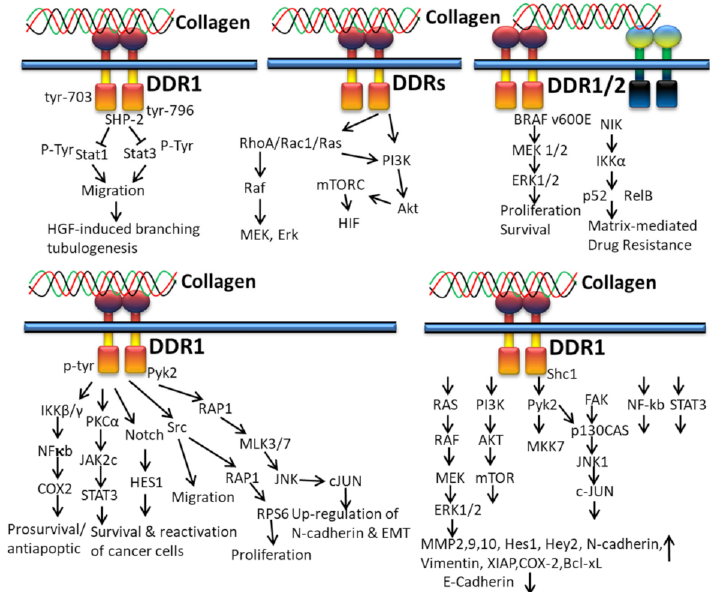
Figure 6. Collagen DDR signals in